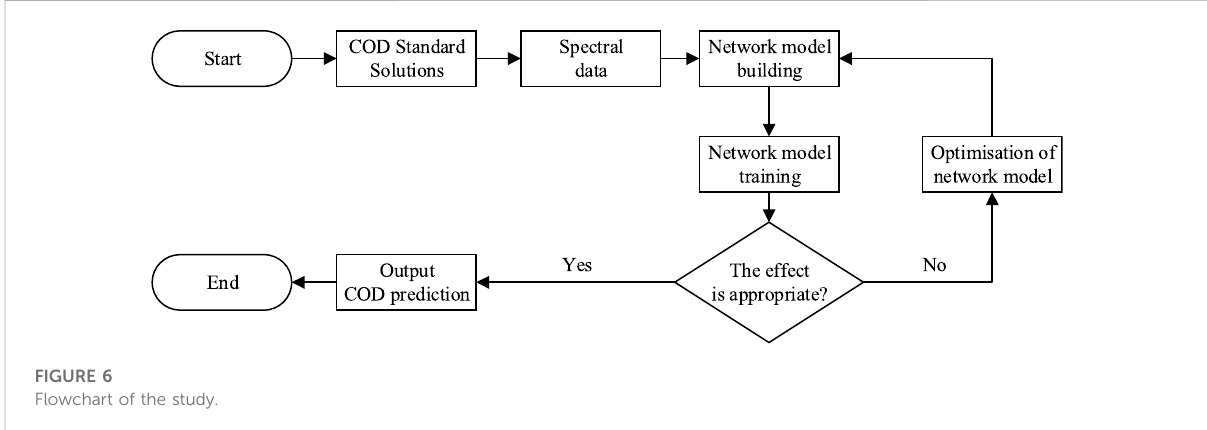
FIGURE 6 Flowchart of the